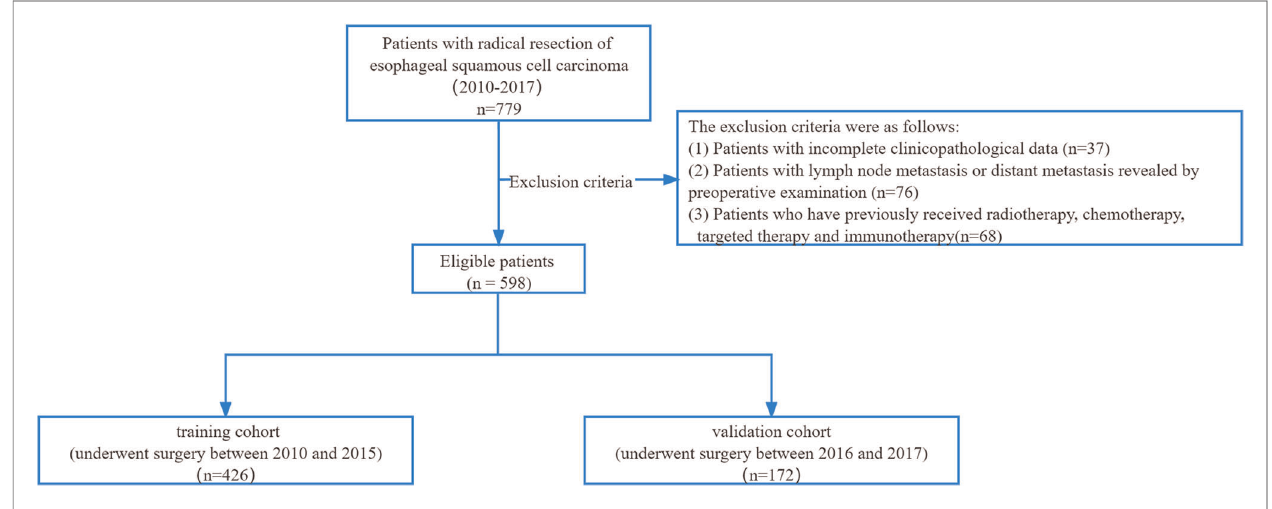
FIGURE 1 | Study fl ow chart.